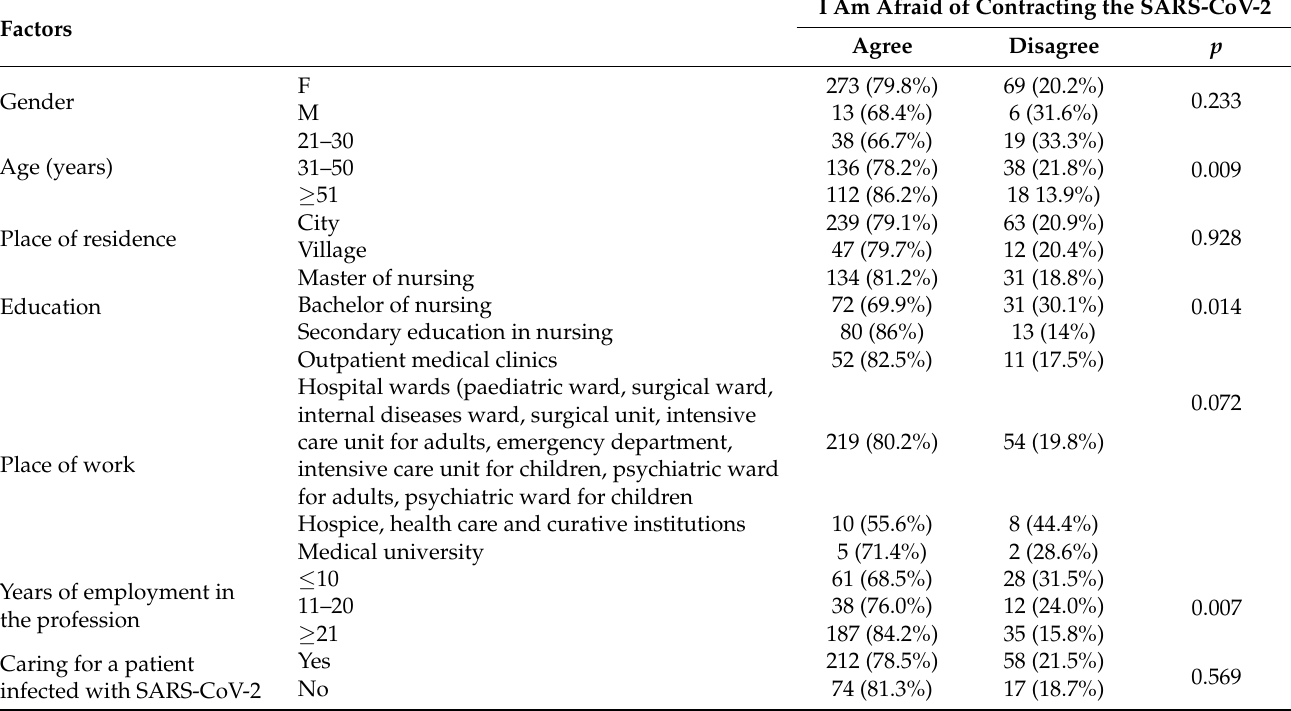
Table 2. Influence of various factors on fear of SARS-CoV-2